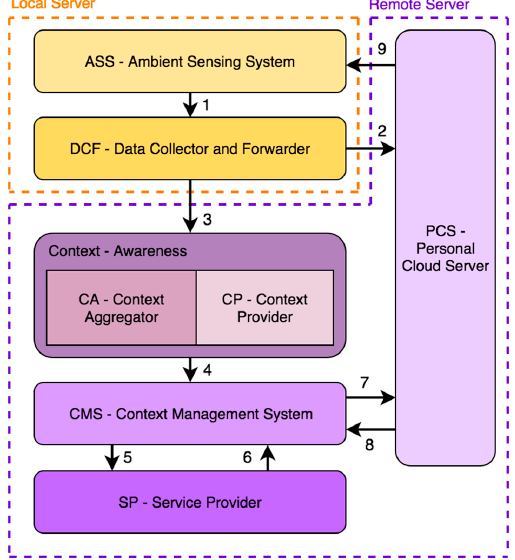
Figure 1. General diagram of the BDCaM architecture showing the main elements of the system, as well as the data flows between them: ( 1 ) raw data; ( 2 ) raw data for storage; ( 3 ) raw data to process; ( 4